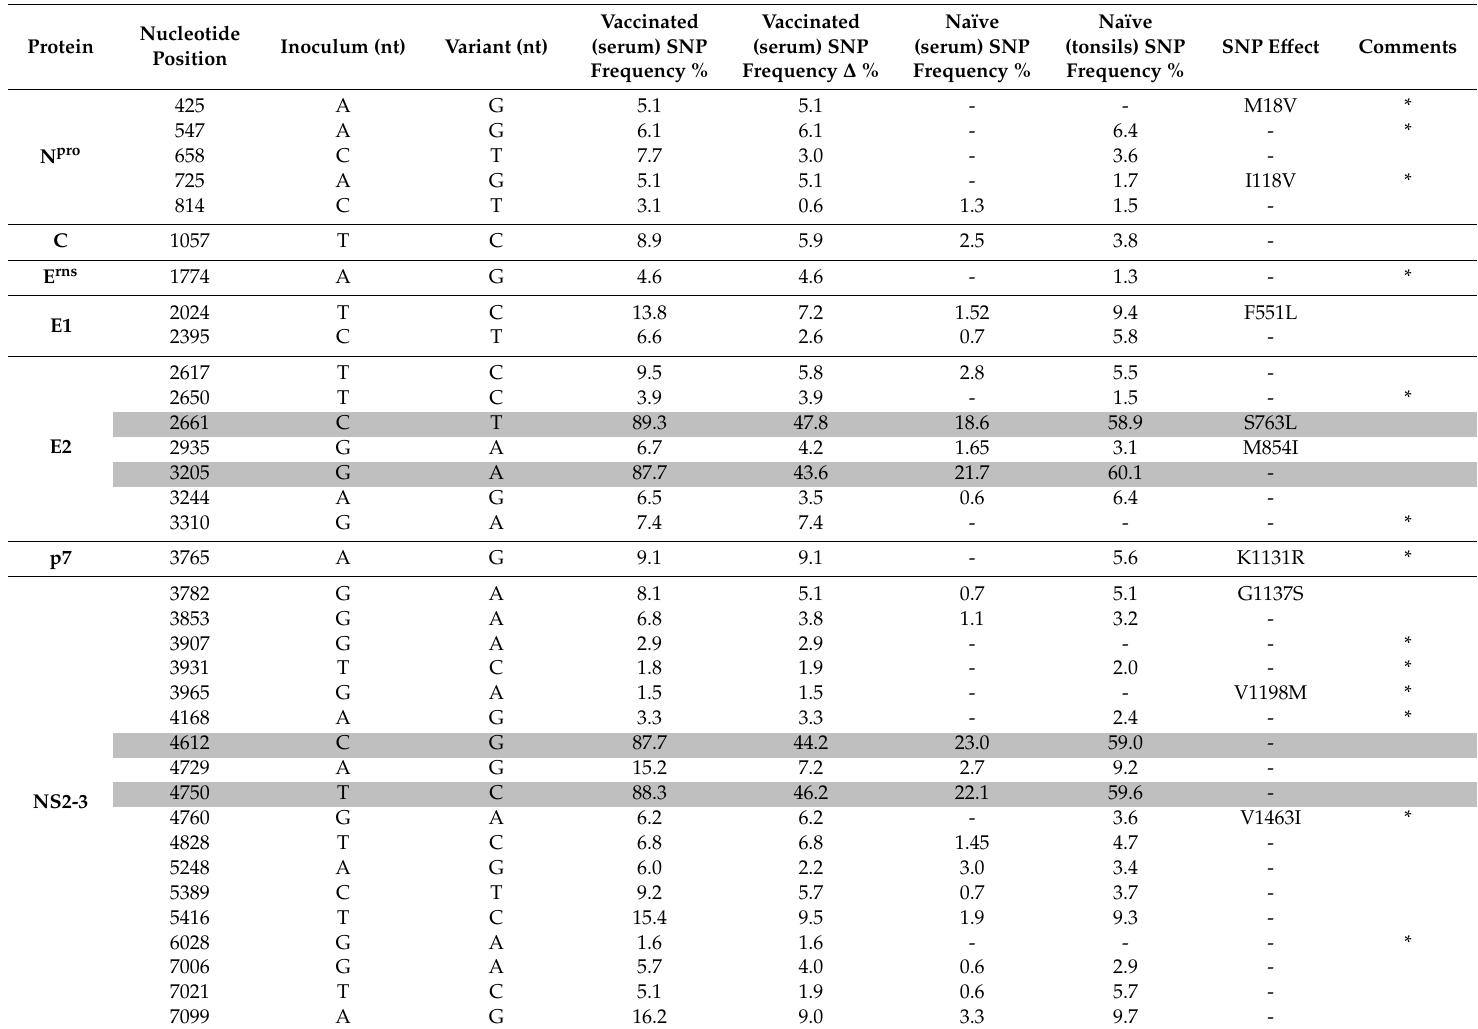
Table 1. SNPs in vaccinated animals compared to naïve